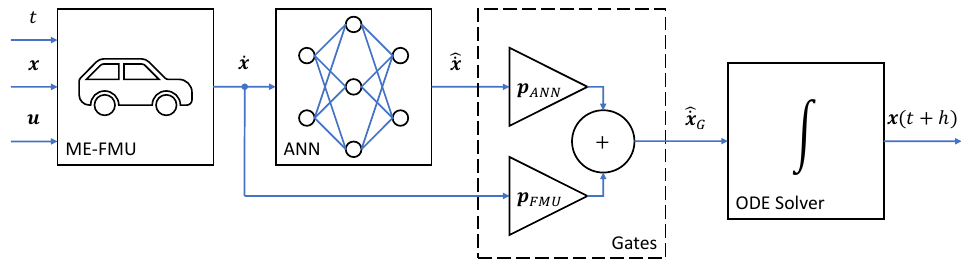
Figure 7. ME-NeuralFMU with FPM/ANN gates: The ME-FMU receives the current time t and state x from the numerical ODE solver together with an external input u and computes the corresponding state derivative ˙ x . Two gates p ANN and p FMU scale how many dynamic changes by the ANN and the FMU are introduced to the derivative vector ˆ˙ x G . Finally, the derivative vector ˆ˙ x G is passed to the ODE solver with the (adaptive) step size h and integrated into the next system state x ( t + h )